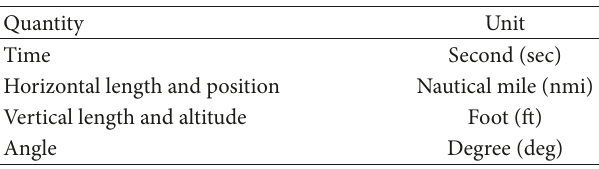
Table 1: Physical